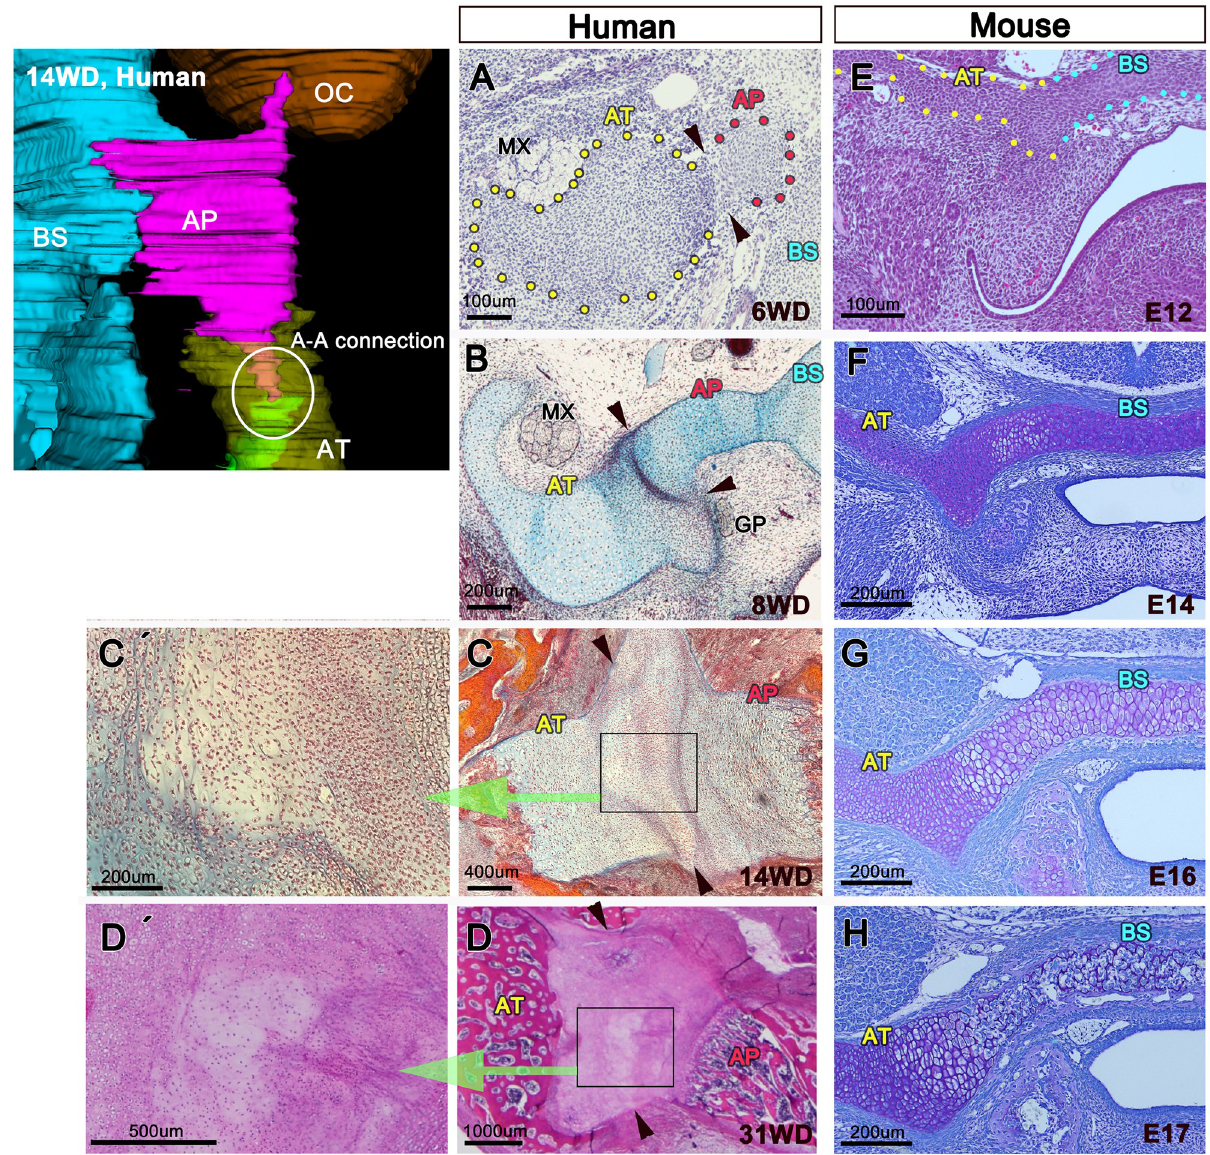
Fig 6. A-A connection in humans and mice. (A–D) A-A connection in humans (arrowheads). (C’ and D’) Enlargement of (C and D), respectively. (E– H) Middle cranial base in mice. Histological analysis in humans showed an unusual structure (A-A connection) between the AT and the AP. Mice do not have the A-A connection. AP, alar process; AT, ala temporalis; BS, basisphenoid; GP, greater petrosal nerve; MX, maxillary nerve; OC, otic